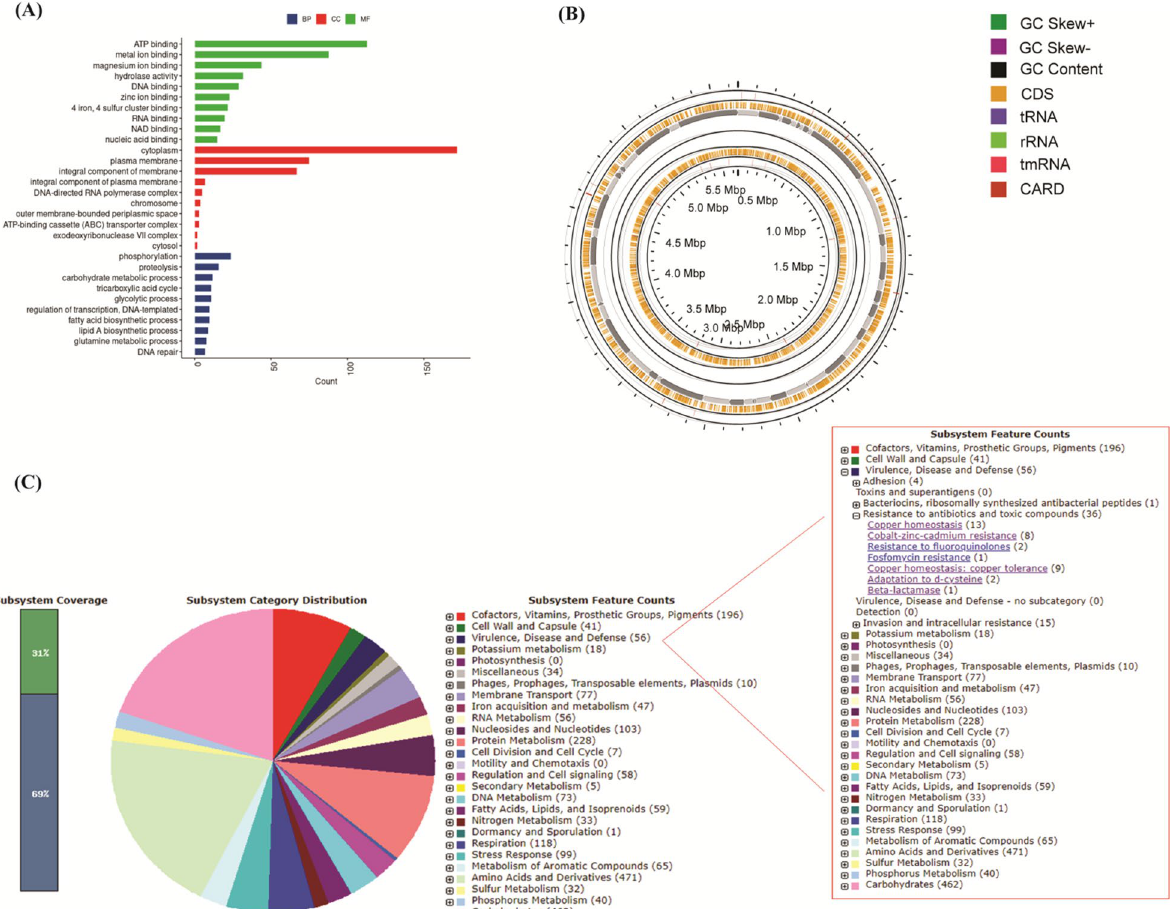
Fig. 4 The gene ontology biological process, circular graphical and subsystem distribution of R. planticola FACU 3. A Top 10 Biological process (BP), Cellular component (CC) and molecular function gene ontologies generated by UniprotR, B the circular graphical display of the distribution of R. planticola FACU 3 genome which includes CDS on the forward strand, CDS on the reverse strand, RNA genes, GC content, positive and negative GC skew and antibiotic resistance genes. The figure was prepared by CGView circular genome visualization tool and C the subsystem coverage and category distribution of R. planticola FACU 3 genome utilizing RAST. The pie chart demonstrates the counts for each subsystem feature and the subsystem coverage. Genes for each Subsystem Category were displayed in